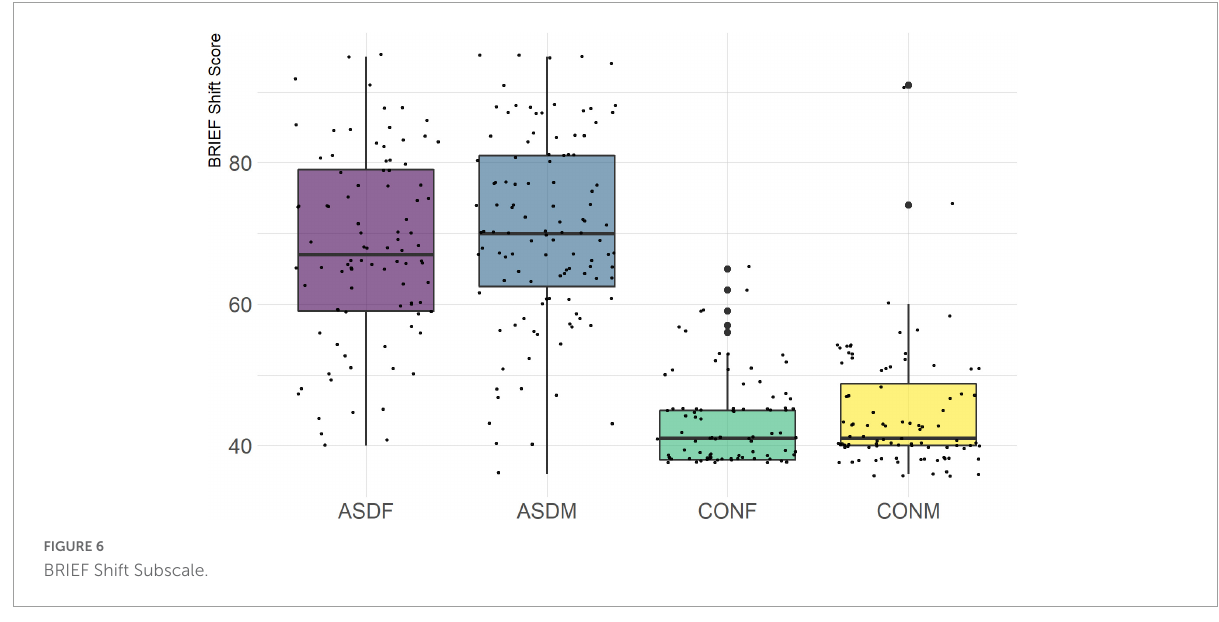
FIGURE6 BRIEF Shift Subscale.